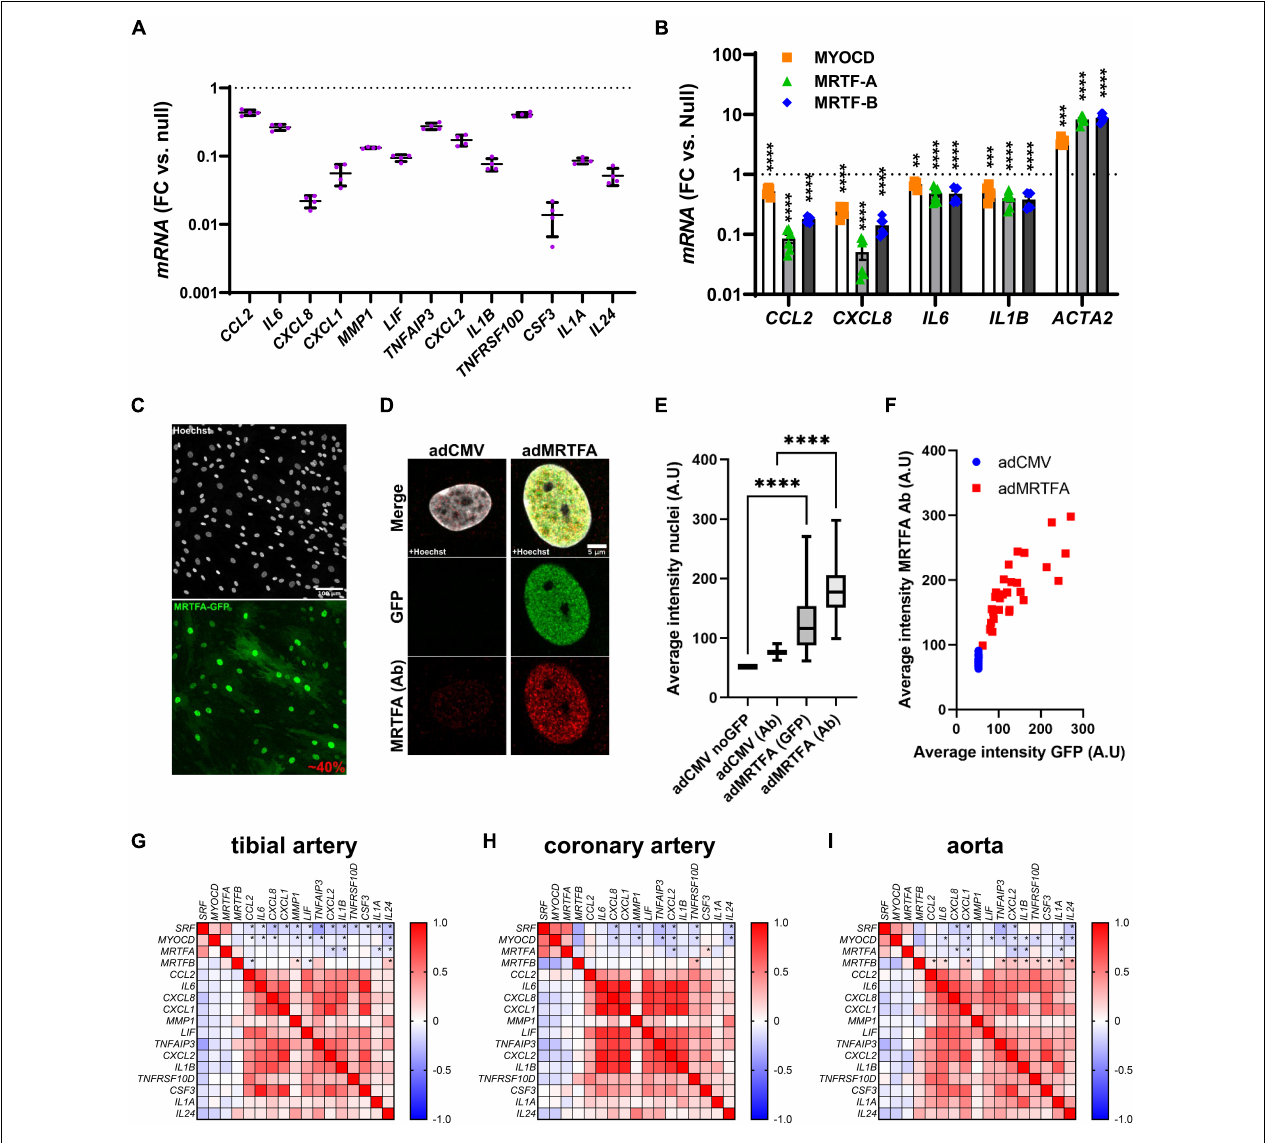
FIGURE 1 | Anti-inflammatory effect of all MRTFs in human coronary artery smooth muscle cells (SMCs). (A) Shows mRNA levels for 13 inflammatory mediators in cultured human coronary artery smooth muscle cells (hCASMCs) after myocardin overexpression using an adenovirus (Ad-CMV-MYOCD). FC: fold change; null: Ad-CMV-null virus. Data is from an RNA-sequencing experiments conducted in a parallel study, and the control level is indicated by the dotted line. All changes were significant at an adjusted P < 0.0001. Suppression of inflammatory markers by myocardin (MYOCD) confirms previous studies and stimulated us to consider if this property is shared by all MRTFs. Side-by-side adenoviral transductions suggested that MTRF-A and MRTF-B have the same effect in the same cell type (hCASMCs, (B) ). Confocal imaging showed that 40% of the cells were positive for overexpressed MRTF-A as shown using an eGFP tagged construct (C) and a general nuclear stain (Hoechst). In (D) , overexpressed and endogenous MRTF-A were labeled separately using the eGFP tag and an antibody, respectively. Quantification showed that nuclear labeling increased after viral transduction (E) , as expected, and the nuclear intensity of labeling in the GFP channel increased linearly with MRTF-A antibody staining (F) . We also examined correlations at the mRNA level in human arteries (G–I) . RNA-seq data was downloaded from the GTExPortal.org and correlation matrices were generated in GraphPad Prism using the Pearson method. Negative correlations (negative R -values, blue fills) were seen for SRF and MYOCD vs. inflammatory mediators in all arteries. Significant correlations are indicated by (*) for the first four rows in each matrix. MRTFA performed less well than MYOCD and SRF with only a handful significant and negative correlations in each artery. MRTFB performed poorly, and in this case many correlations were positive. These findings suggested a more pronounced anti-inflammatory impact of MYOCD , and MRTFA compared to MRTFB in the intact human vascular wall, despite similar effects upon overexpression in vitro . ** P < 0.01, *** P < 0.001, **** P < 0.0001.